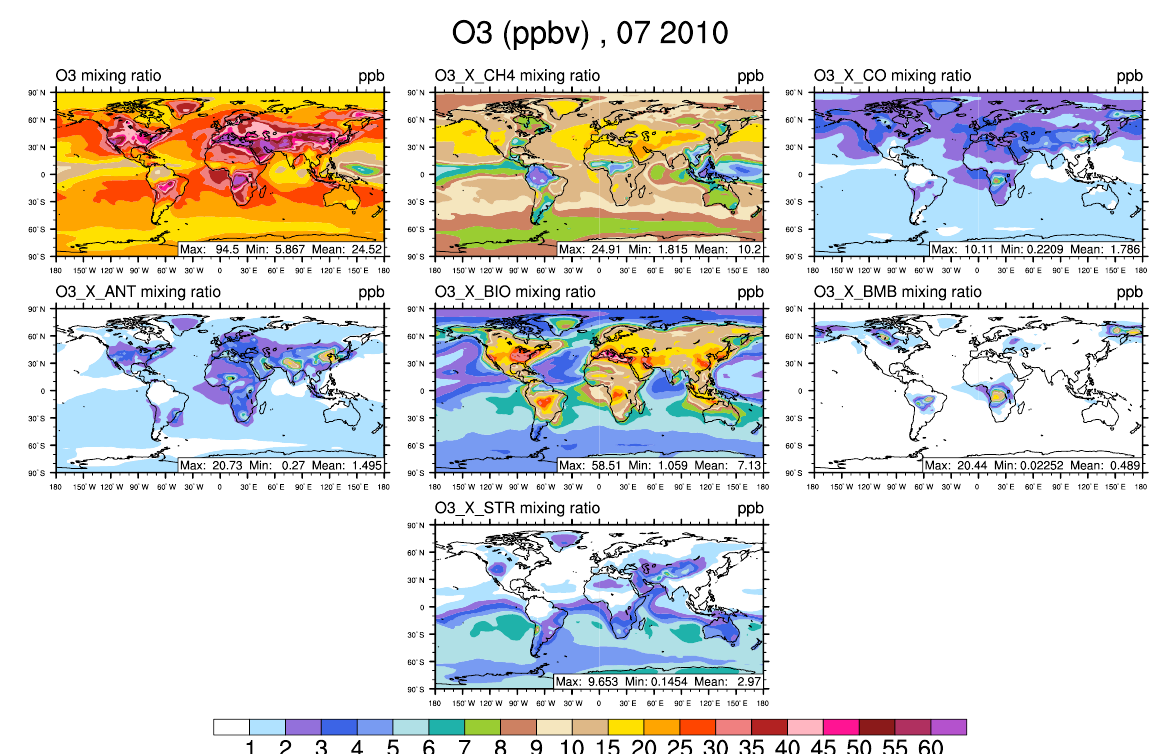
Figure 4. Surface ozone in July from the VOC-tagging run. Total surface ozone is shown in the top left panel. Other panels show the contribution to surface ozone due to methane (CH4), all CO emissions (CO), anthropogenic NMVOC sources (ANT), biogenic NMVOC sources (BIO), biomass burning NMVOC sources (BMB), and transport from the stratosphere (STR).